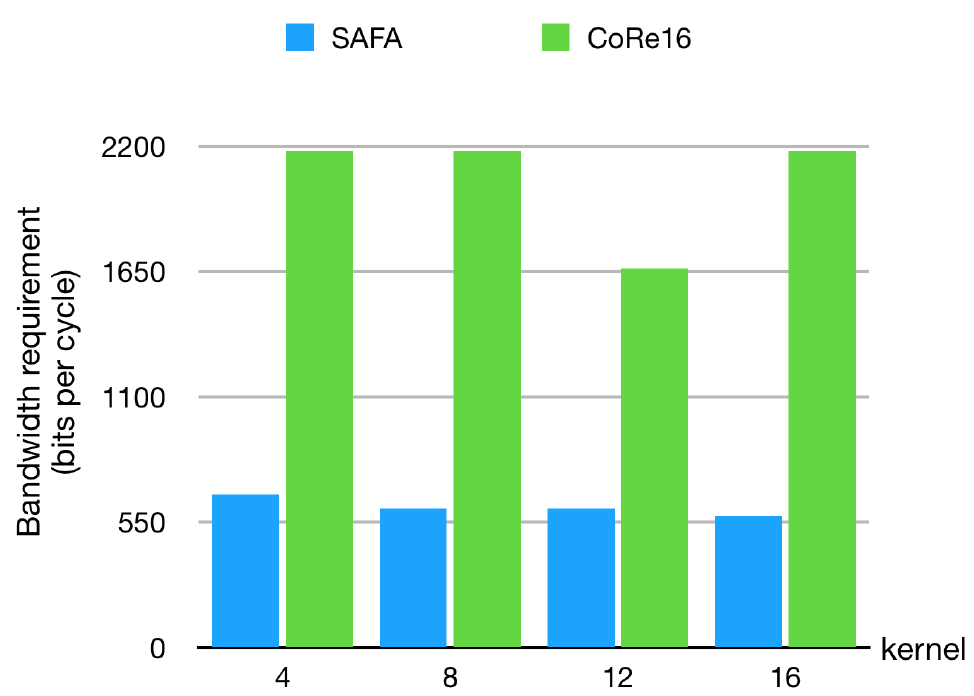
Figure 7. Storage bandwidth requirement for both SAFA and CoRe16. The storage bandwidth of SAFA is reduced by 3.53 times on average under different kernels (except for kernel =